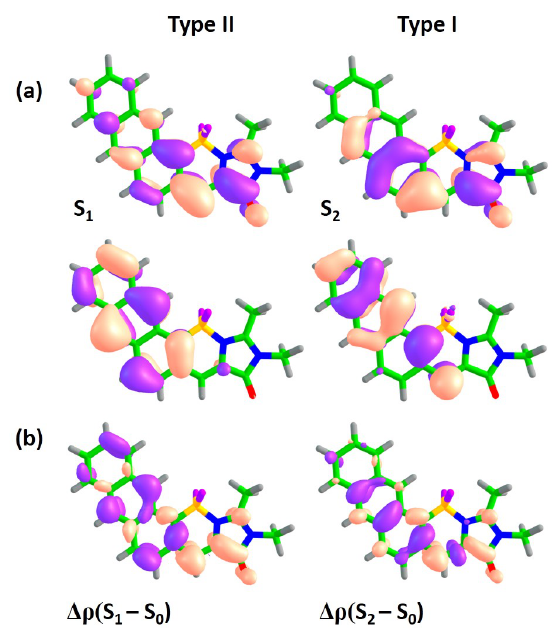
Figure 7. XMCQDPT2 natural orbitals actively involved in the S 0 –S 1 and S 0 –S 2 transitions ( a ) and the corresponding differential electron densities ∆ ρ ( b ) for compound 2D . For each state, the excitation is directed from the lower orbital to the higher orbital. The color code stands for negative and positive ∆ ρ values depicted in blue and red,